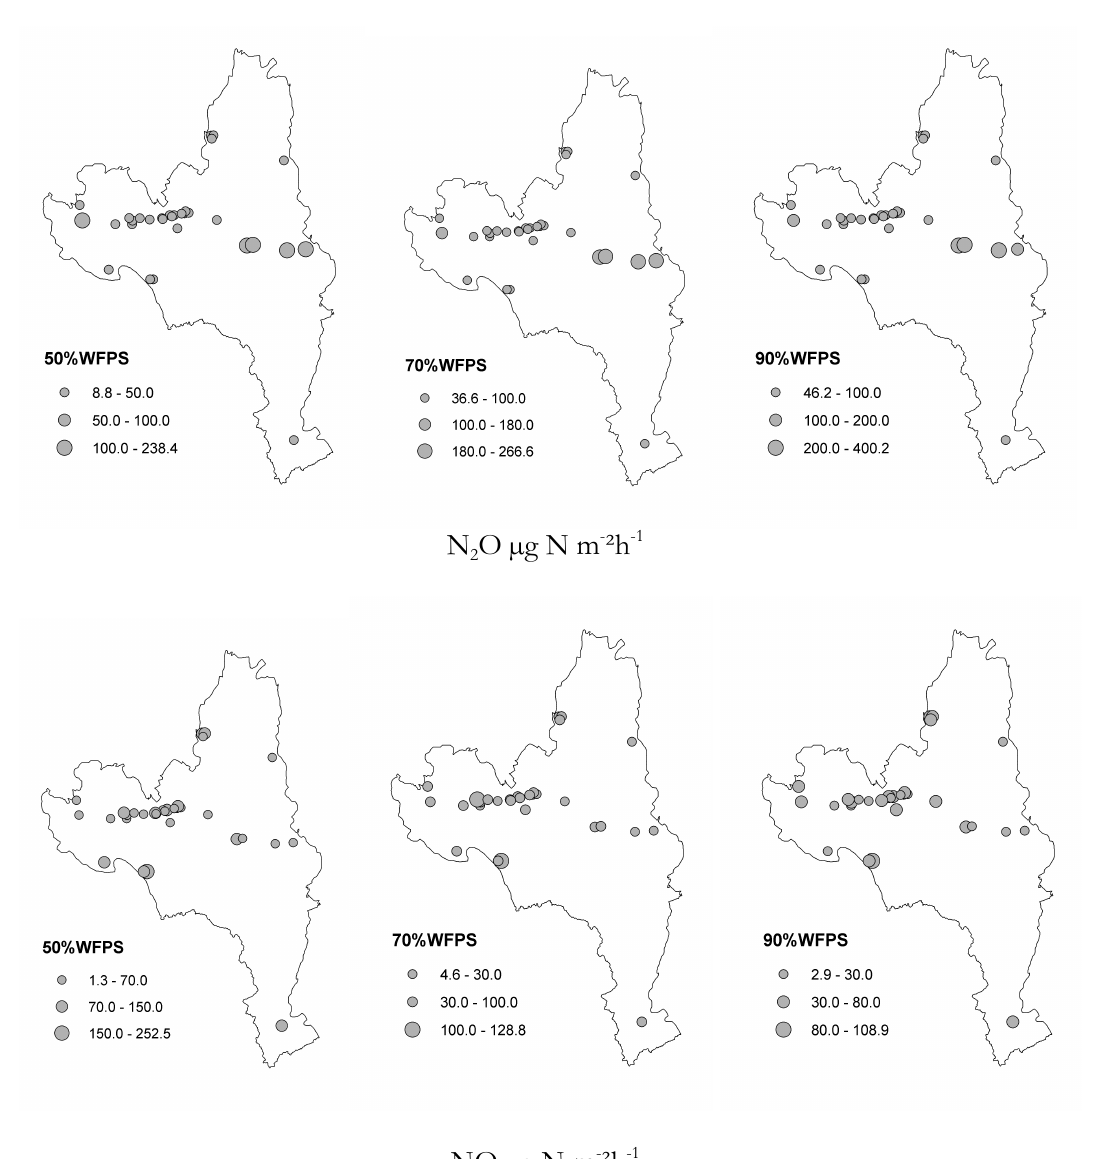
Fig. 4. Spatial distribution of N 2 O (top) and NO (bottom) emission rates in the Nyungwe forest.